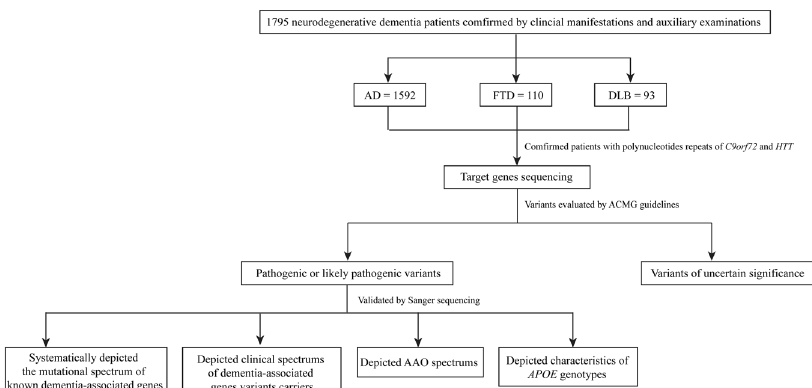
Fig. 5 Work fl ow of this study. AD Alzheimer ’ s disease, FTD frontotemporal dementia, DLB dementia with Lewy